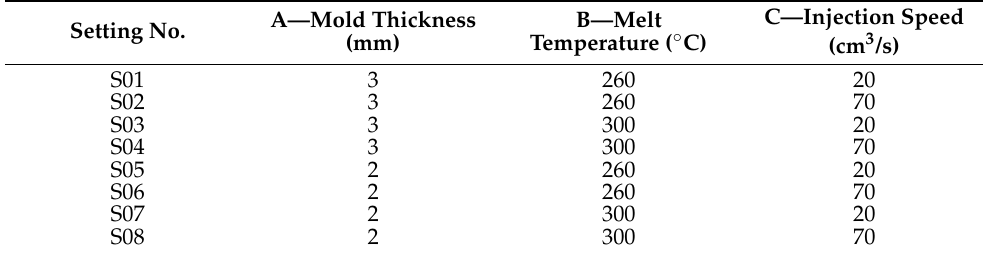
Table 3. Performed injection molding